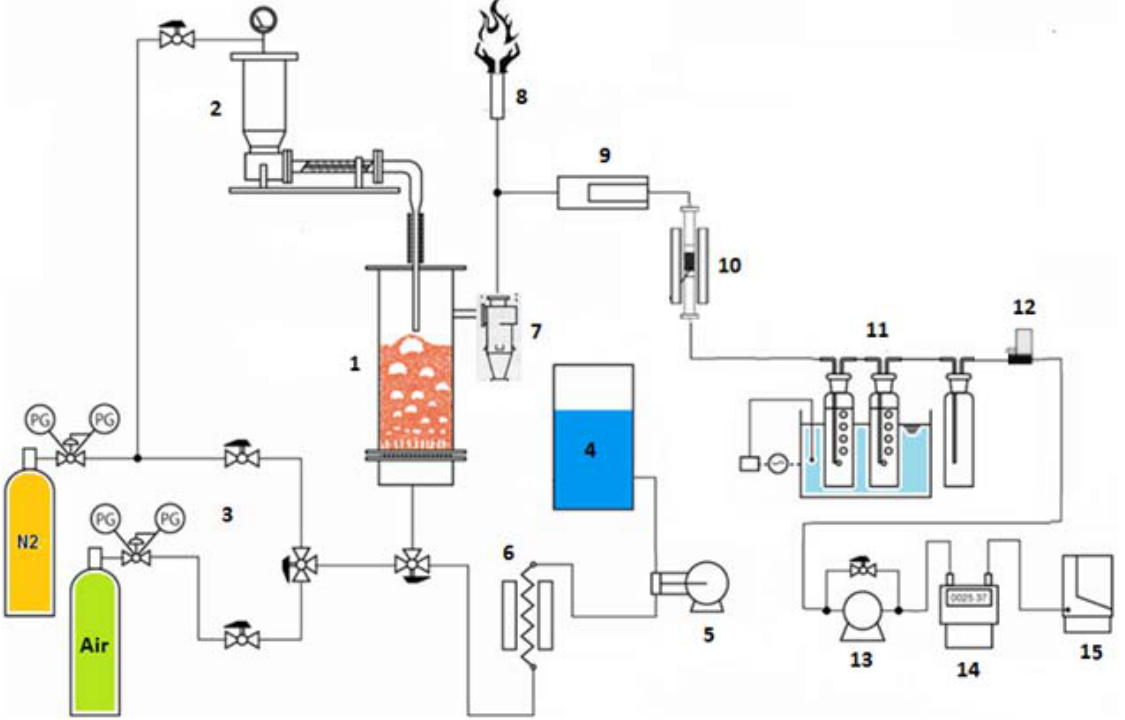
Figure 1. Scheme of the experimental system: (1) bubbling fluidized bed gasifier; (2) biomass feed system—hopper and screw feeder; (3) gasifying agents inlet system; (4) distilled H O storage; (5) water pump; (6) electric steam generator; (7) cyclone; 2 (8) torch; (9) ceramic candle filter; (10) secondary reactor; (11) TAR condensation system; (12) mass flow controller (13) vacuum pump; (14) cumulative gas flow meter; (15) gas-chromatograph